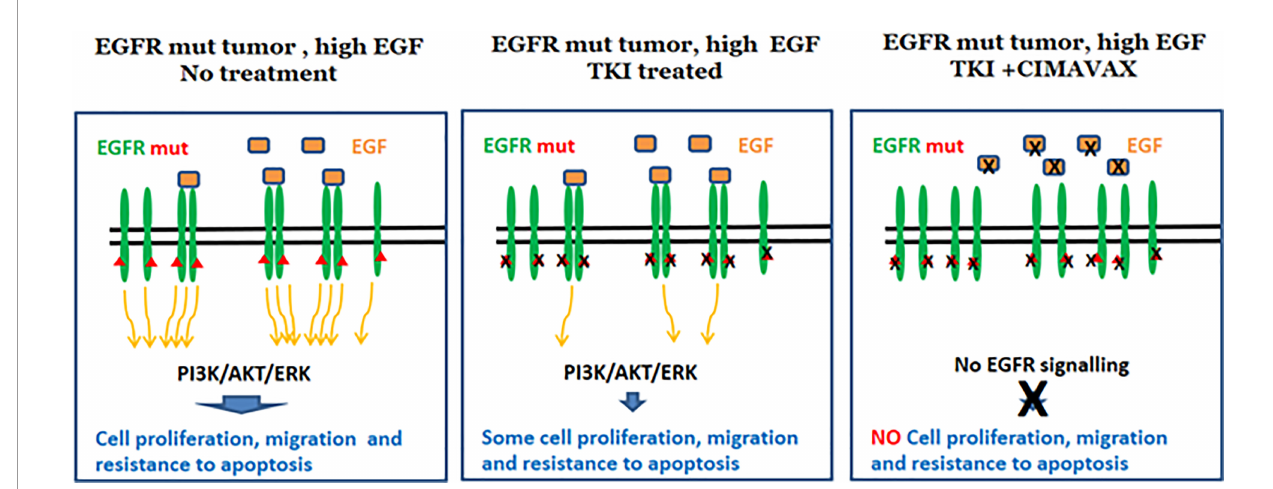
FIGURE 6 | Rationale for CIMAvax-EGF combination with EGFR-TKI. Dual inhibition potentiates EGFR signaling